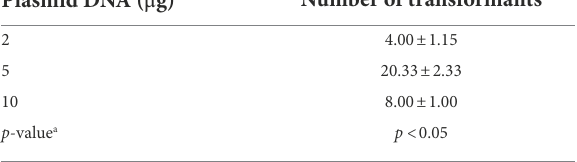
TABLE 3 The effect of plasmid amount on the number of transformants (mean ± SE).